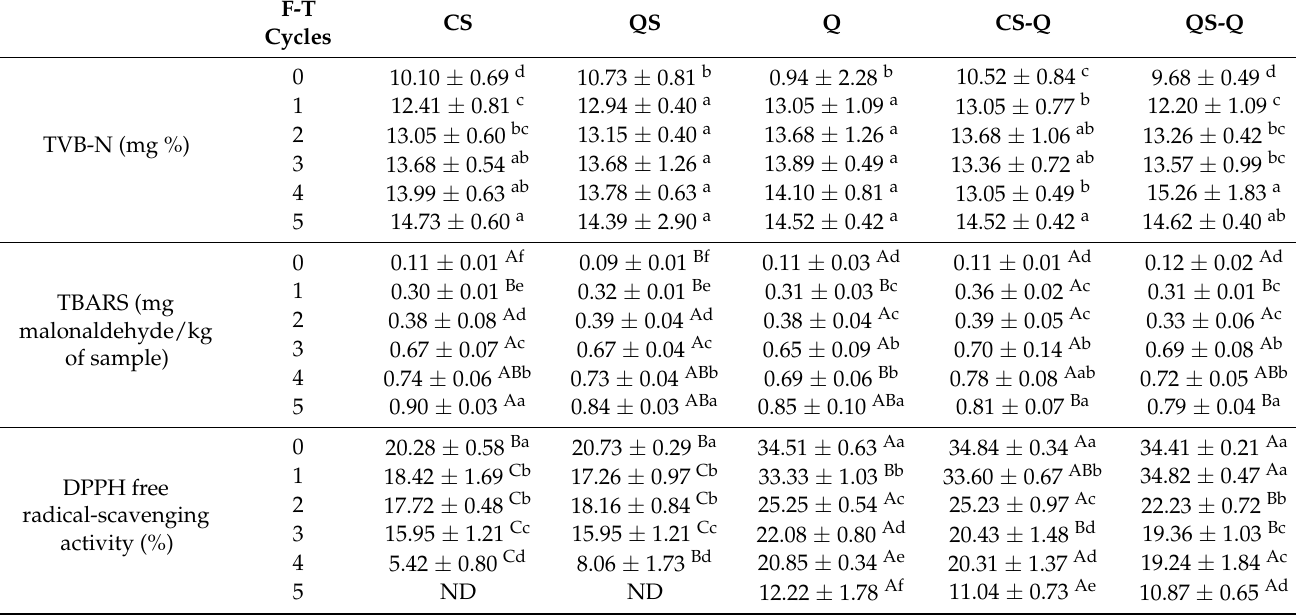
Table 3. Total volatile basic nitrogen (TVB-N), thiobarbituric acid reactive substances (TBARS) value, and diphenyl-1- picrylhydrazyl (DPPH) value of the chicken meatballs during five F-T cycles.